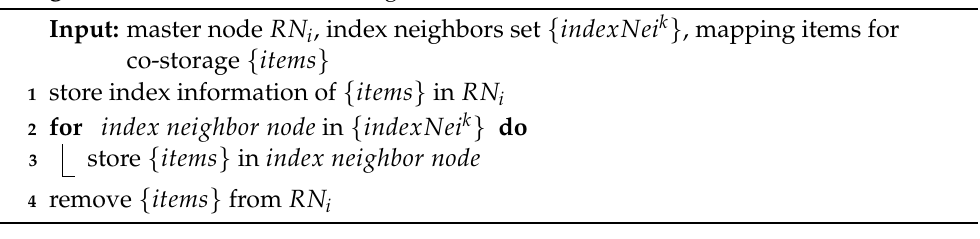
Algorithm 4: Collaborative